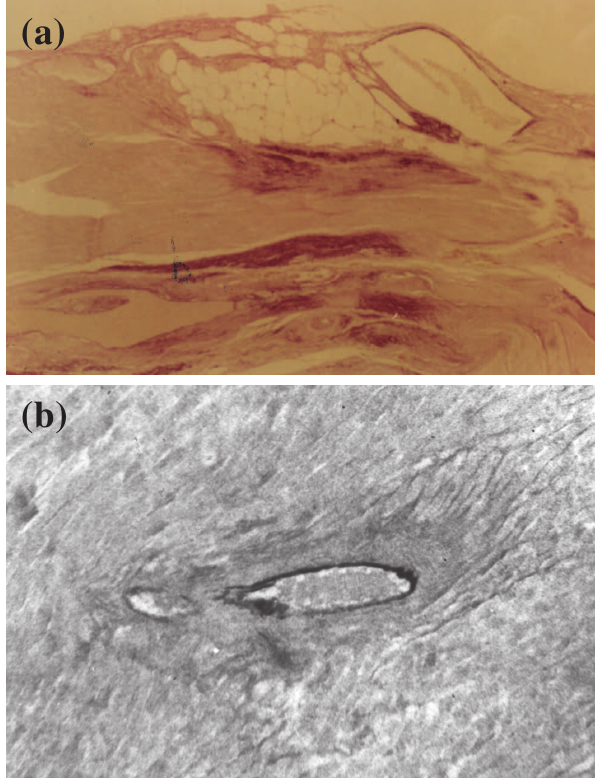
Figure 3 - (a) Myocardium with intense reaction by oxytalan fibers (dark dots) of the elastic system in reparative fibrotic areas (Weigert’s resorcinol-fuchsin method using an oxone reaction; magnification 100X); (b) perivascular fibrosis characteristic of the hypertensive cardiac processes using the L-NAME model. Note the degeneration of the inner elastic lamina and lack of reaction for oxytalan fibers of the elastic system (Weigert’s resorcinol-fuchsin solution with oxone; magnification